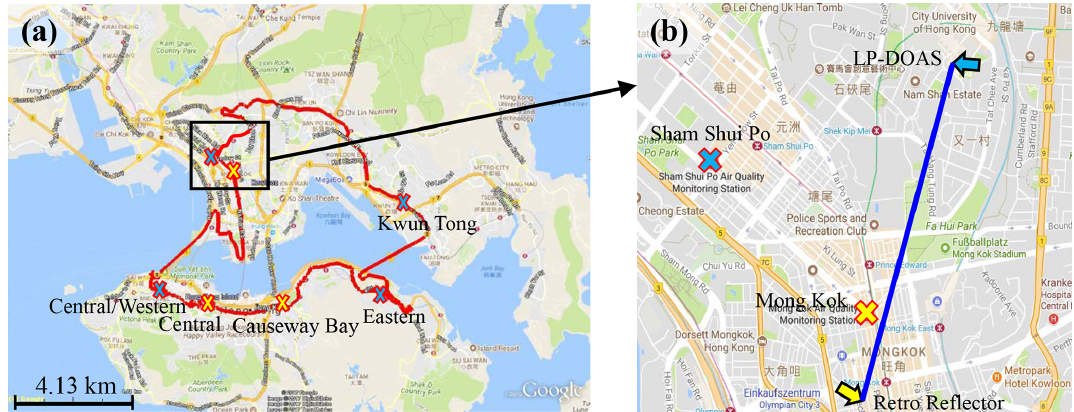
Figure 1. Map of Hong Kong city centre. (a) The standard measurement route; (b) the location of LP-DOAS. Yellow crosses indicate three roadside EPD monitoring stations while blue crosses represent four ambient EPD monitoring stations. The blue line indicated in panel (b) represents the optical path of the LP-DOAS.